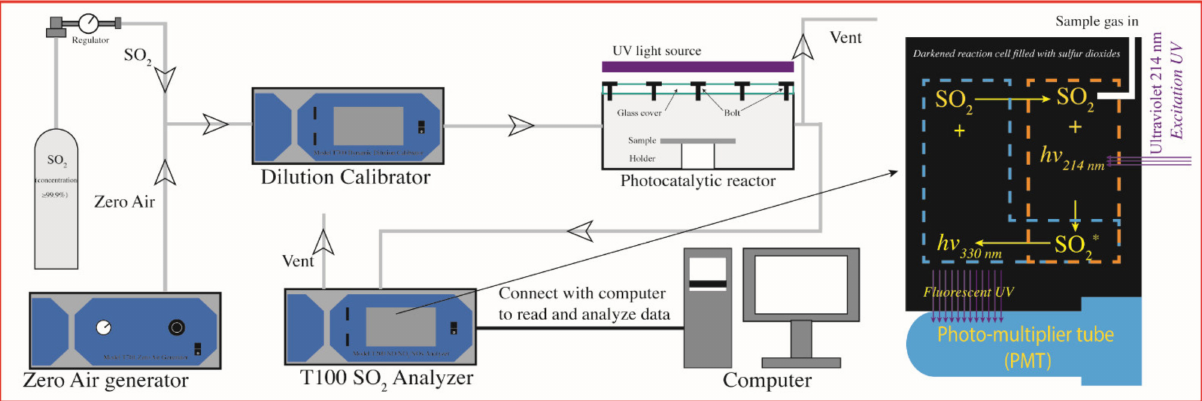
Figure 3. Schematic representation of the photocatalytic reactor and the operation principle of T100 Sulfur Oxides